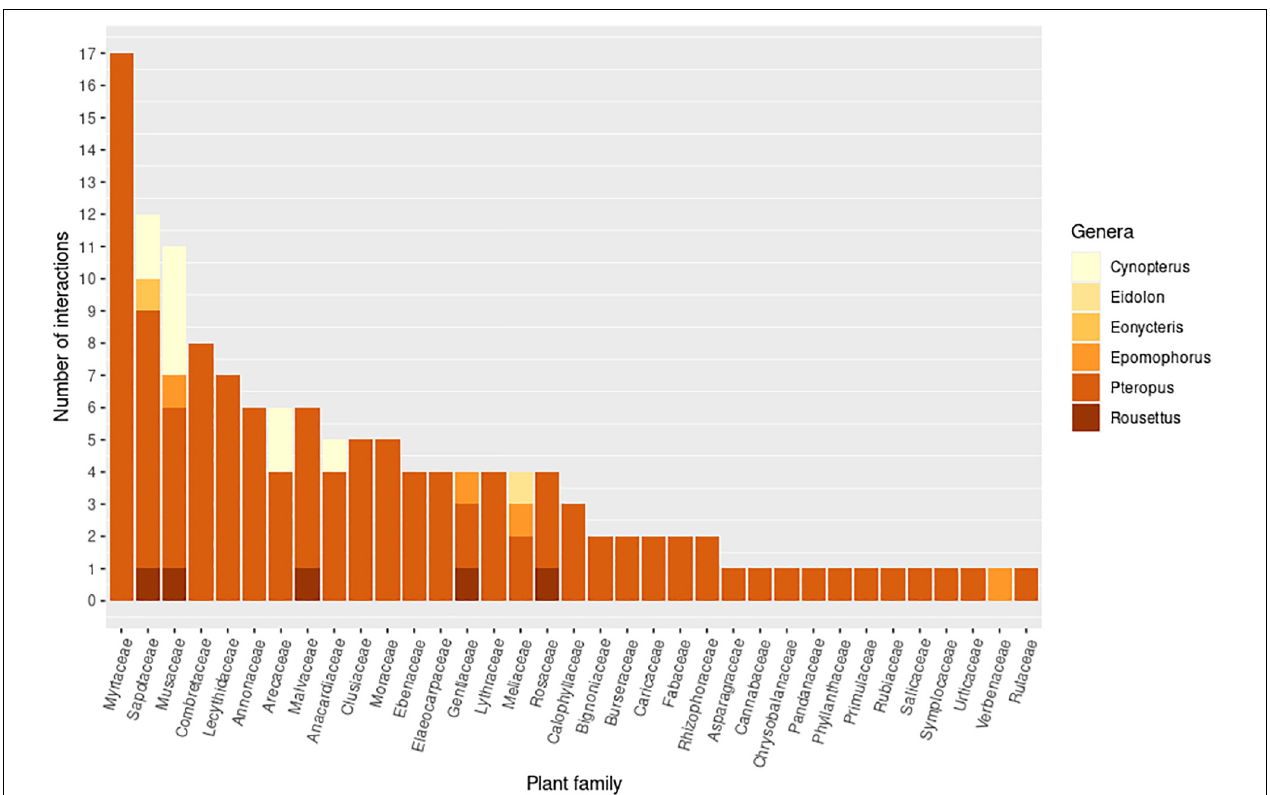
FIGURE 6 | Pteropodid-plant interactions that are potentially double mutualisms, in which a pteropodid species might act as both pollinator and seed disperser for the same plant species. Double mutualisms were assessed at the species level for both plants and bats. The graph shows the number of species-species interactions within each plant family and pteropodid genus. Only families with more than one interaction are shown. Plants in an additional 13 families were recorded for overall pteropodid diet, but only one interaction was recorded for each, and thus not included